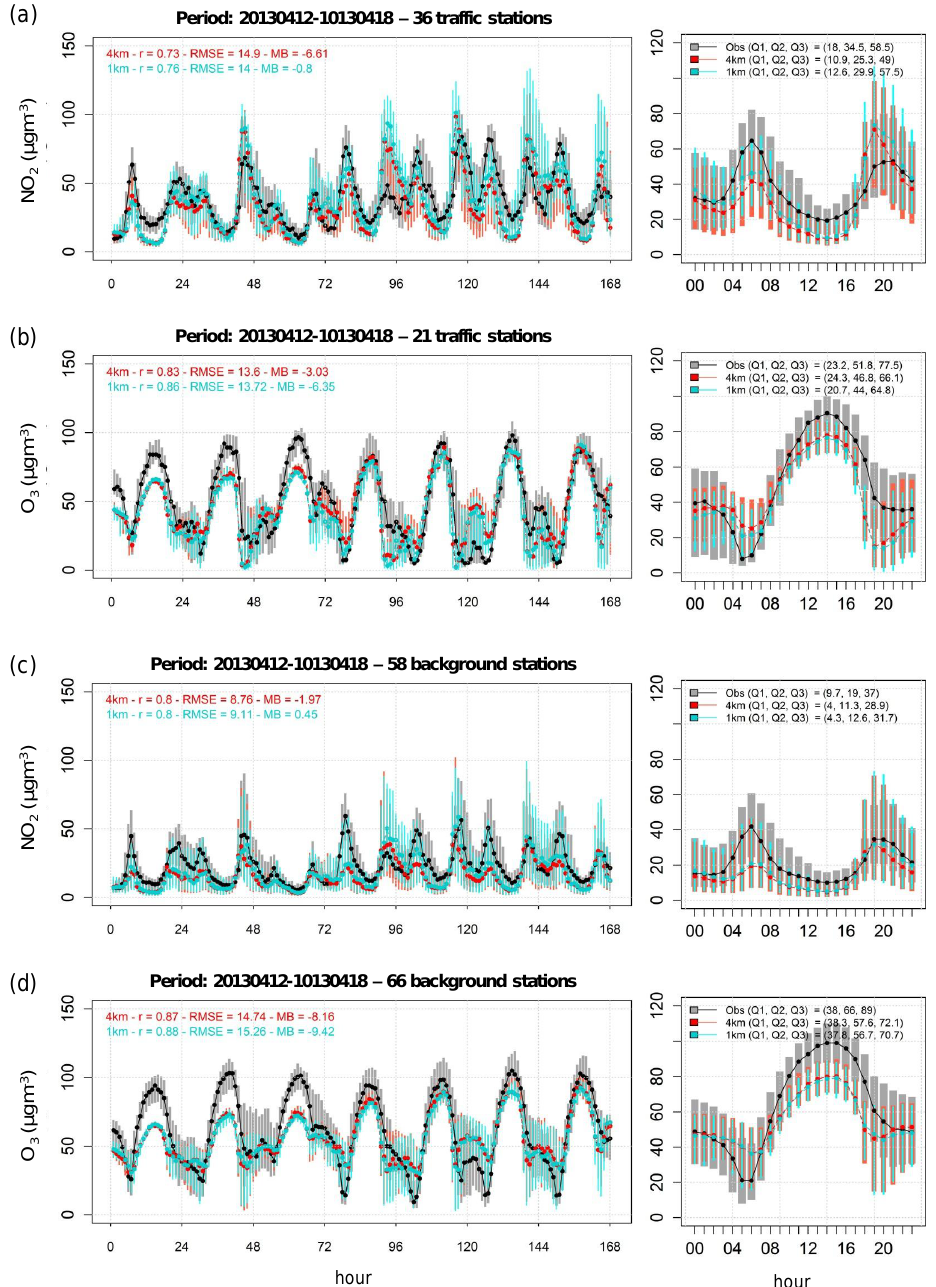
Figure 10. Temporal series and daily cycles for NO 2 and O 3 at background (a and b, respectively) and traffic stations (c and d, respectively) for the episode of 12–18 April 2013. Q1, Q2 and Q3 indicate quartiles for the daily cycle. Bars show Q1 and Q3 at each